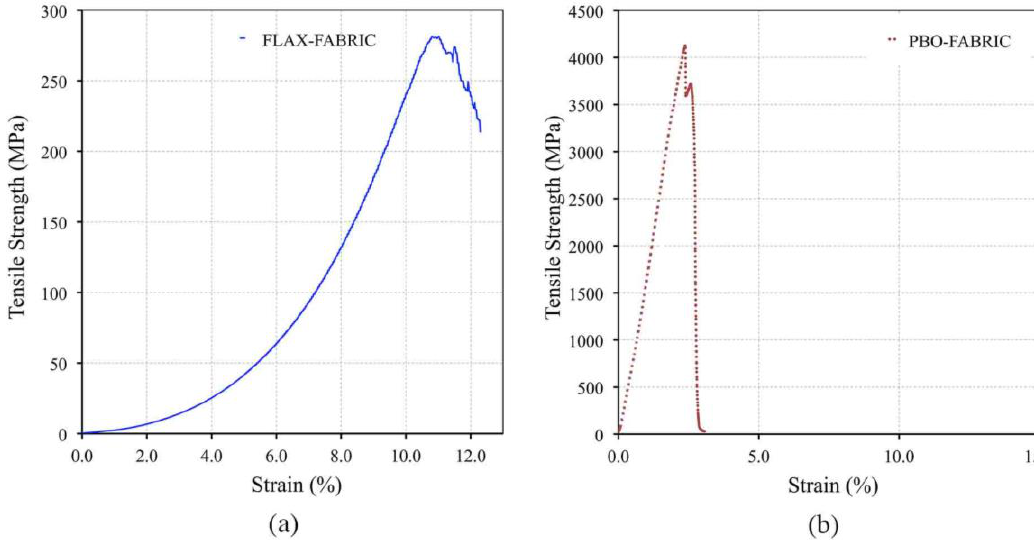
Figure 8. Stress-strain curves of representative fabric specimens: ( a ) flax fabric; ( b ) PBO